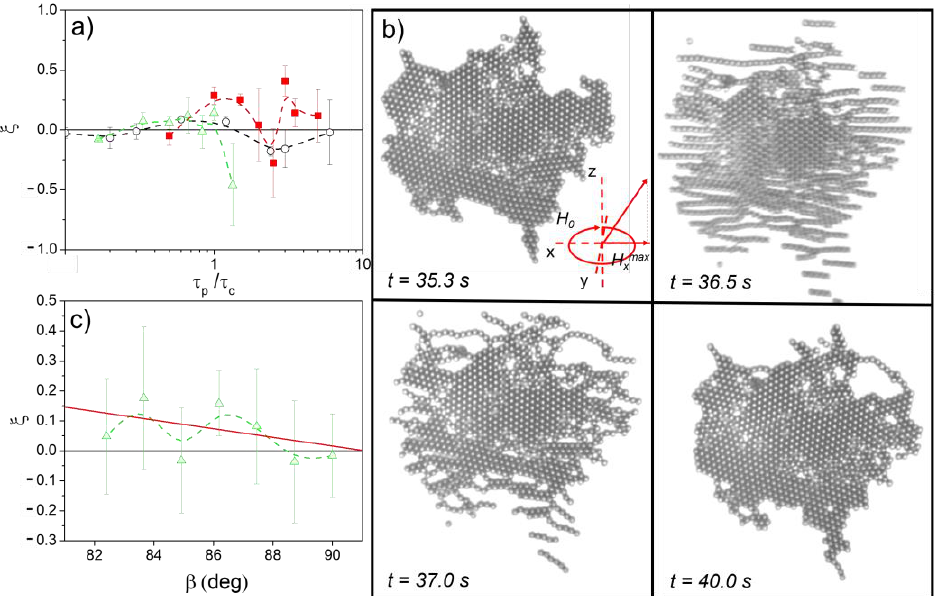
Figure 4. ( a ) In big polycrystals composed of more than 500 particles, the application of field pulses oriented perpendicularly to the fluid interface barely alter the values of ξ. ( b ) A sequence of microscope images showing how the application of tilted pulses, resulting from the simultaneous application of pulses along the Z and X axes, favors the growth of domains oriented along the X direction. ( c ) As 𝛽 decreases, there is a slight enhancement in the hexagonal order, due to the formation of the privileged direction in the polycrystal. µ 0 𝐻 𝑡𝑜𝑡𝑎𝑙𝑒𝑥𝑡 = µ 0 √𝐻 02 + (𝐻 𝑧𝑚𝑎𝑥 ) 2 = 2.0, 5.5 and 8.0 mT for the black circles, green triangles and red squares, respectively.